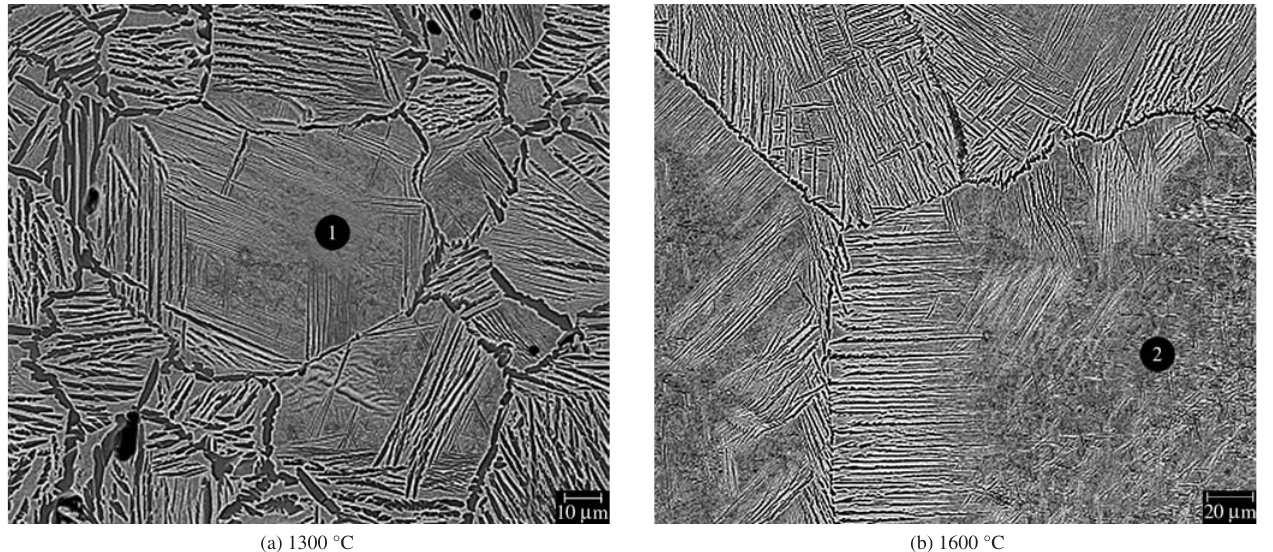
Figure 2. β -phase areas analyzed for EDS in the samples of Ti-35Nb alloy sintered at 1300 °C and 1600 °C.